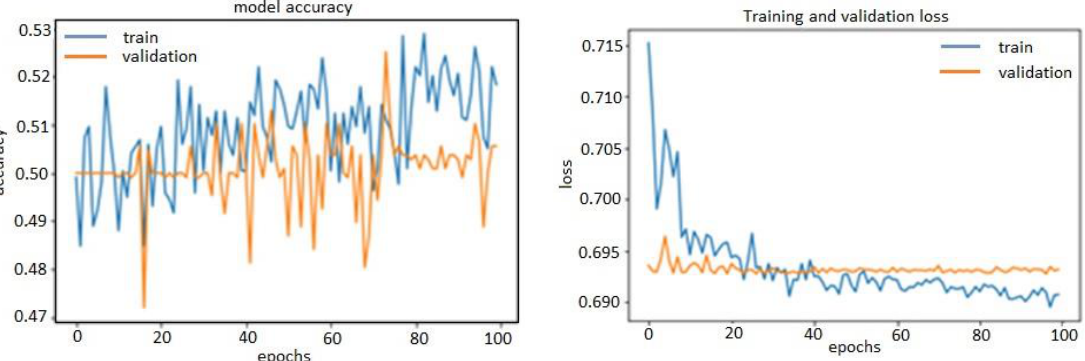
Figure 11. Accuracy and loss model of time-domain features 1D-CNN.